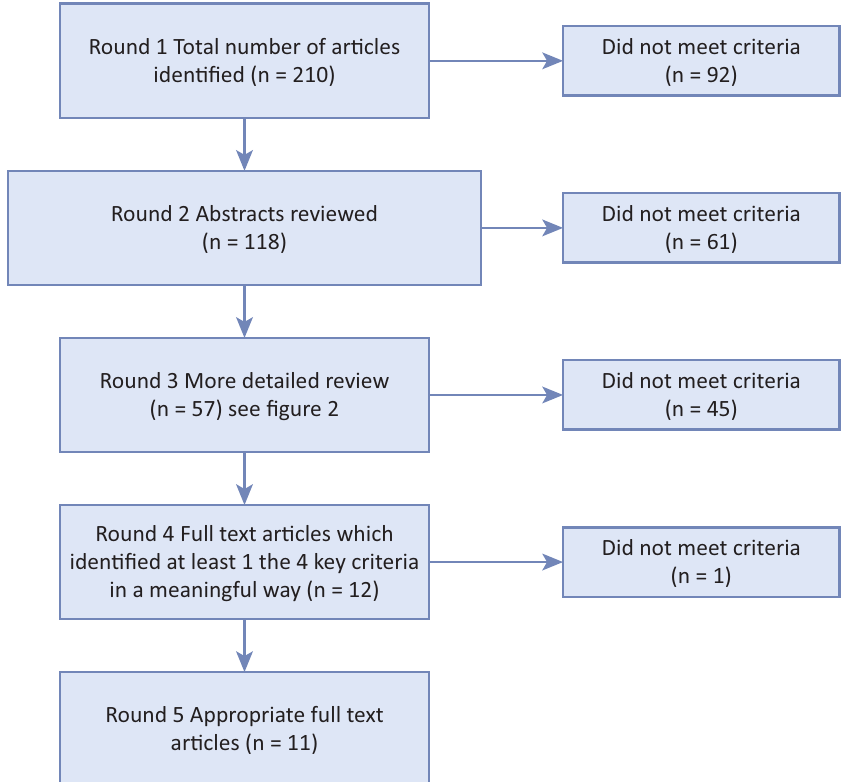
Figure 2. Flow diagram outlining selection process to identify papers that address the four key activity criteria in a mean- ingful